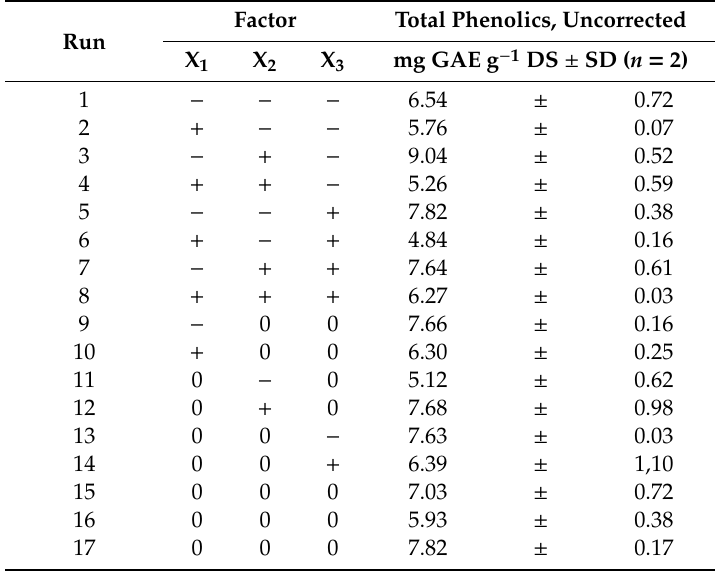
Table 6. Full factorial design for the Central Composite Face (CCF) model with experimental